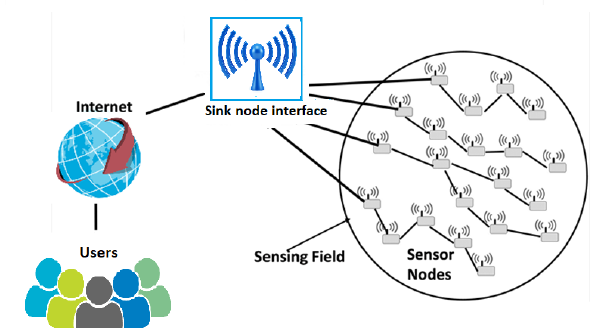
Figure 1: WSN architecture